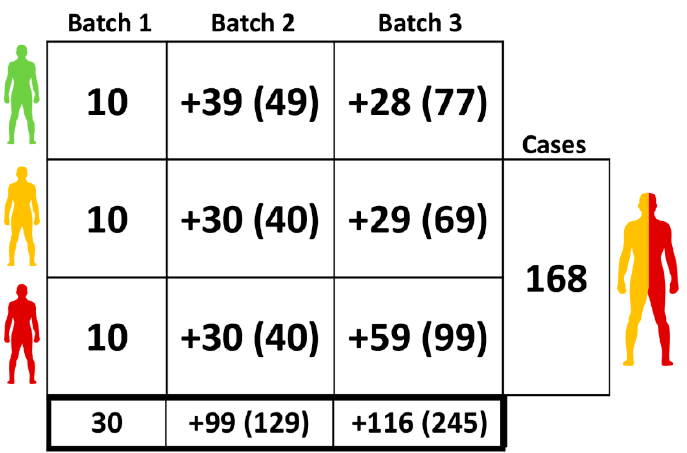
Figure 1. Distribution of samples between the different sample batches. Green human silhouette indicates the CONTROL group (C), yellow one ADENOMA one (AD) and red COLORECTAL CANCER group (CRC). The three batch samples are indicated at the top of each column and the total number of samples per batch in the final row. The n per group per batch is represented in cells, while between parentheses the cumulative number of samples per group is shown.